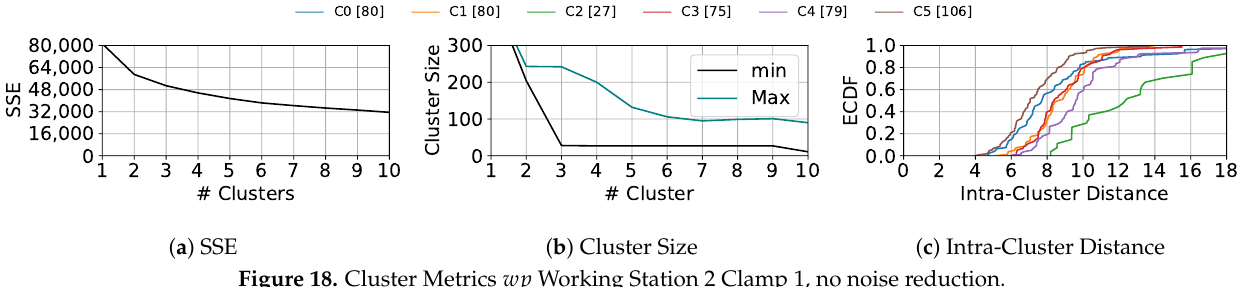
Figure 18. Cluster Metrics wp Working Station 2 Clamp 1, no noise reduction.